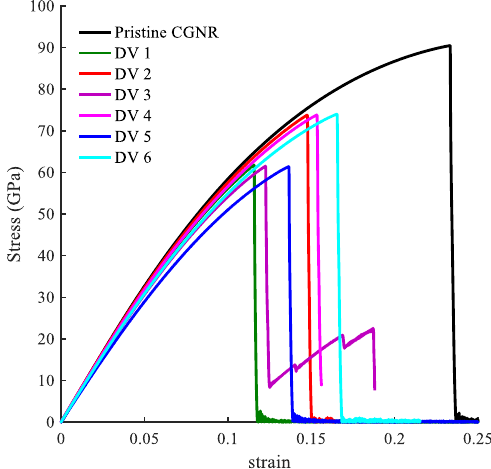
Figure 13. Stress–strain curves of CGNR with single and multiple defects.